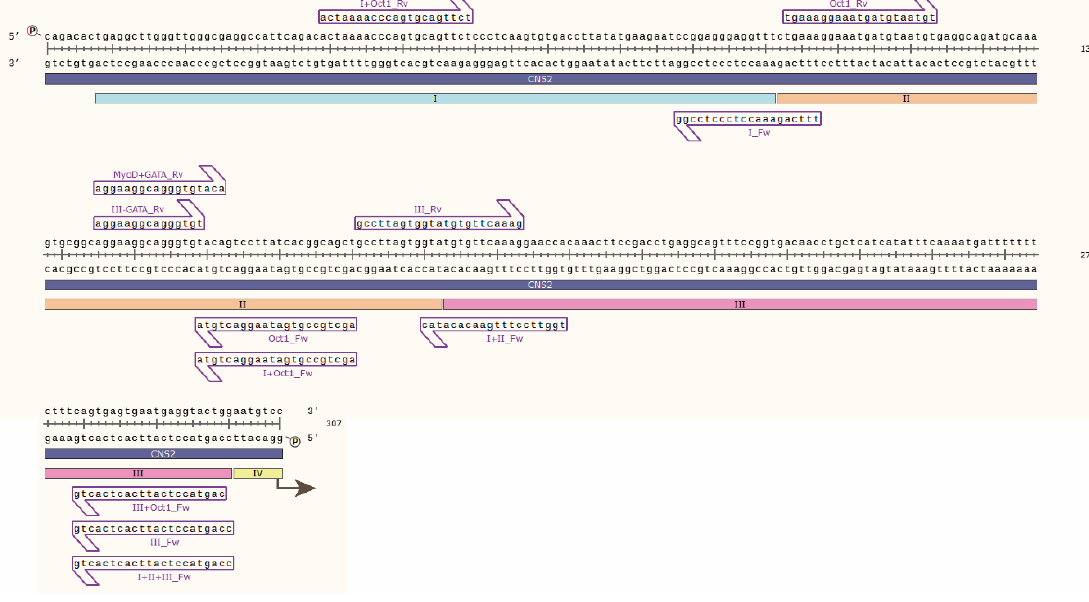
to amplify the CNS2 sequences used in the luciferase experiments are depicted as purple arrows.